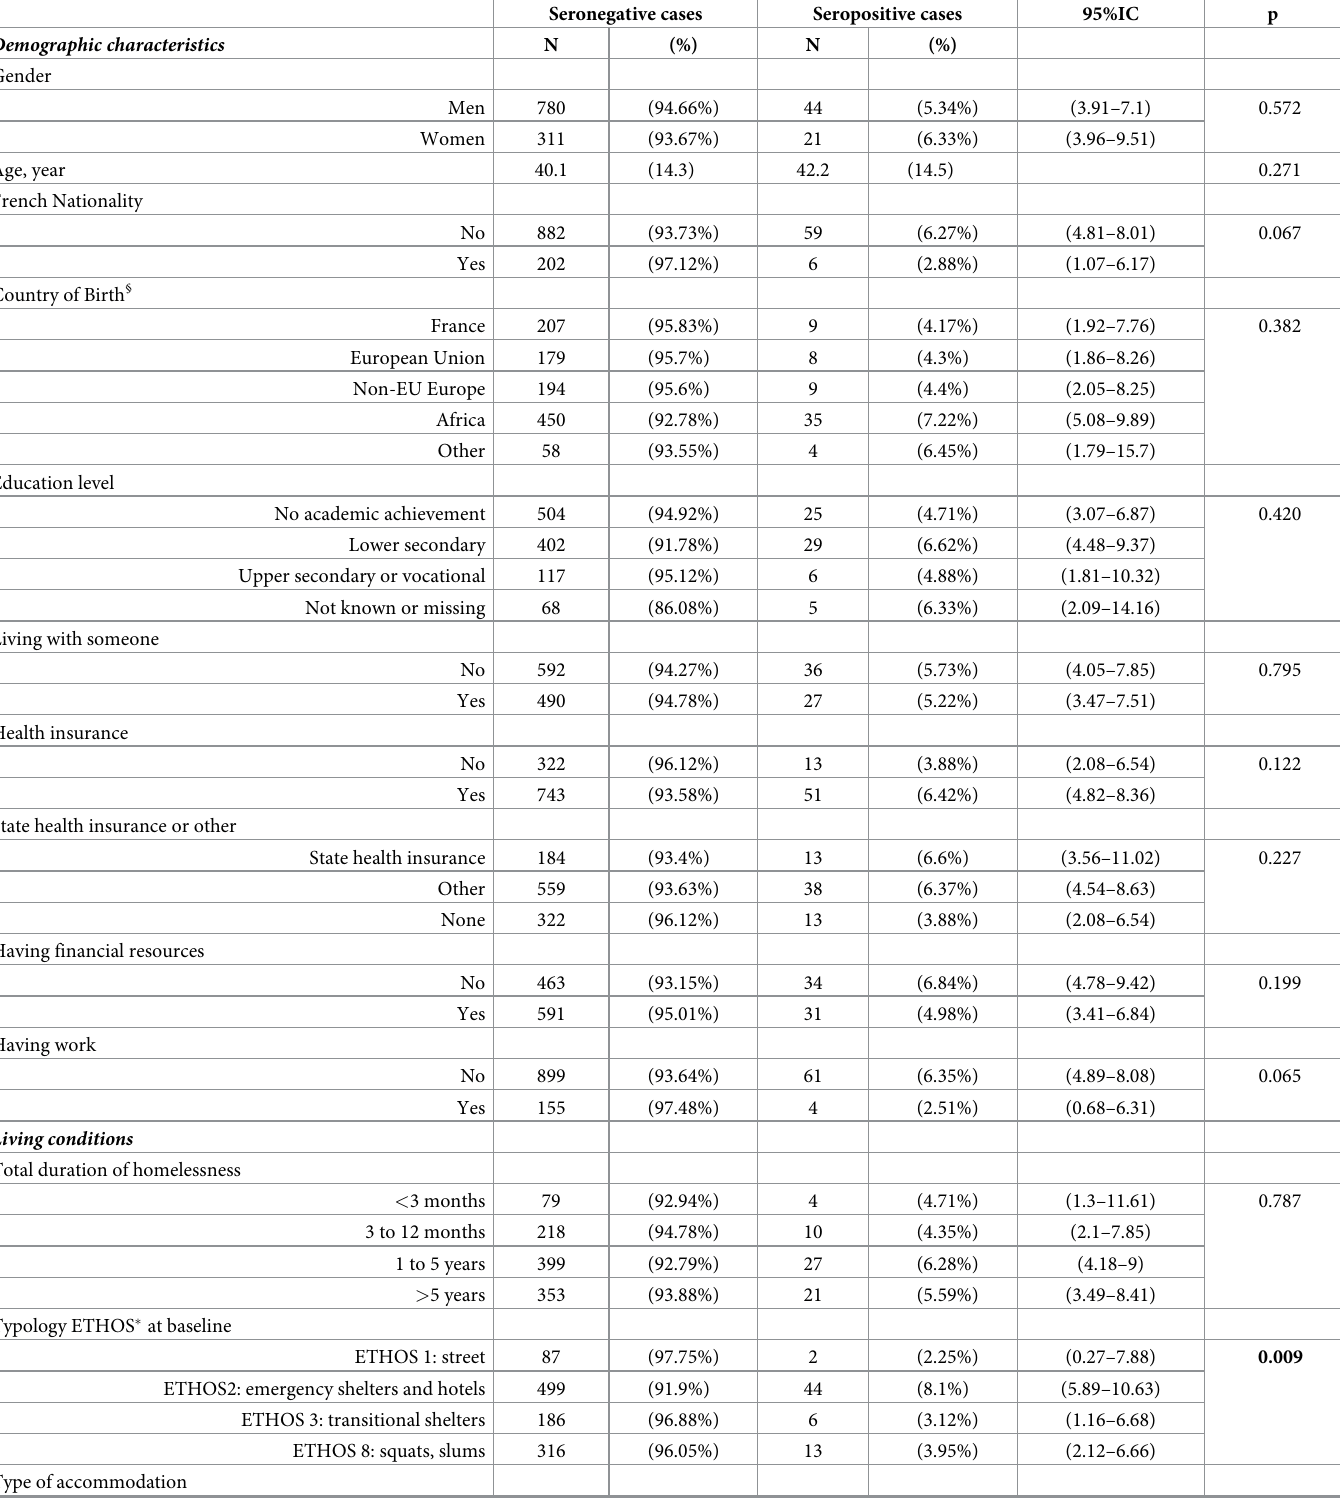
Table 3. Seroprevalence of SARS-CoV-2 according to demographic characteristics, living conditions, health characteristics and comorbidities (N =